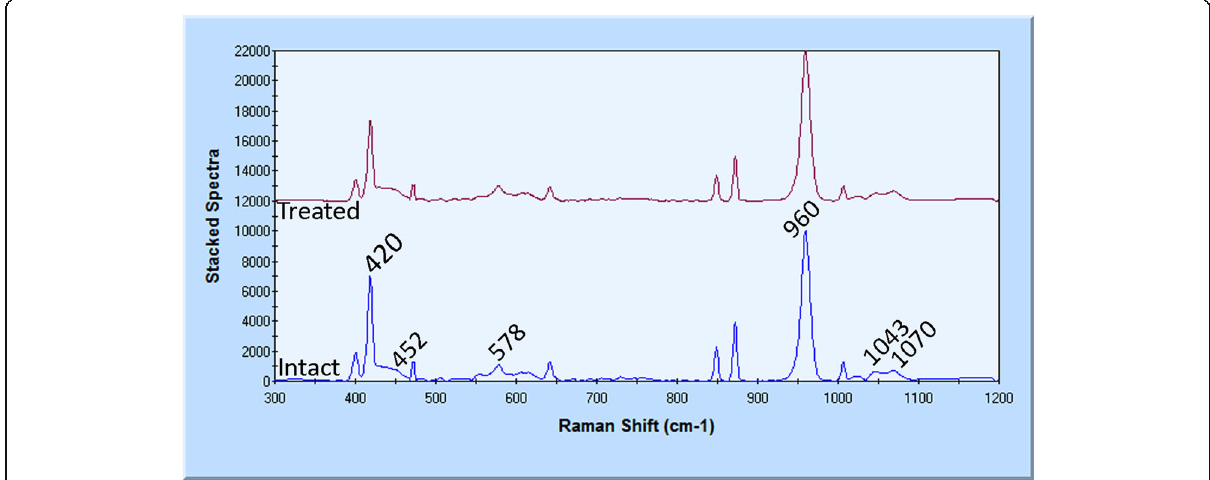
Fig. 5 Raman spectra from the surface of intact and treated enamel showing phosphate (420, 452, 578, and 960 cm − 1 ) and carbonate (1043 and 1070 cm − 1 ) main vibrational